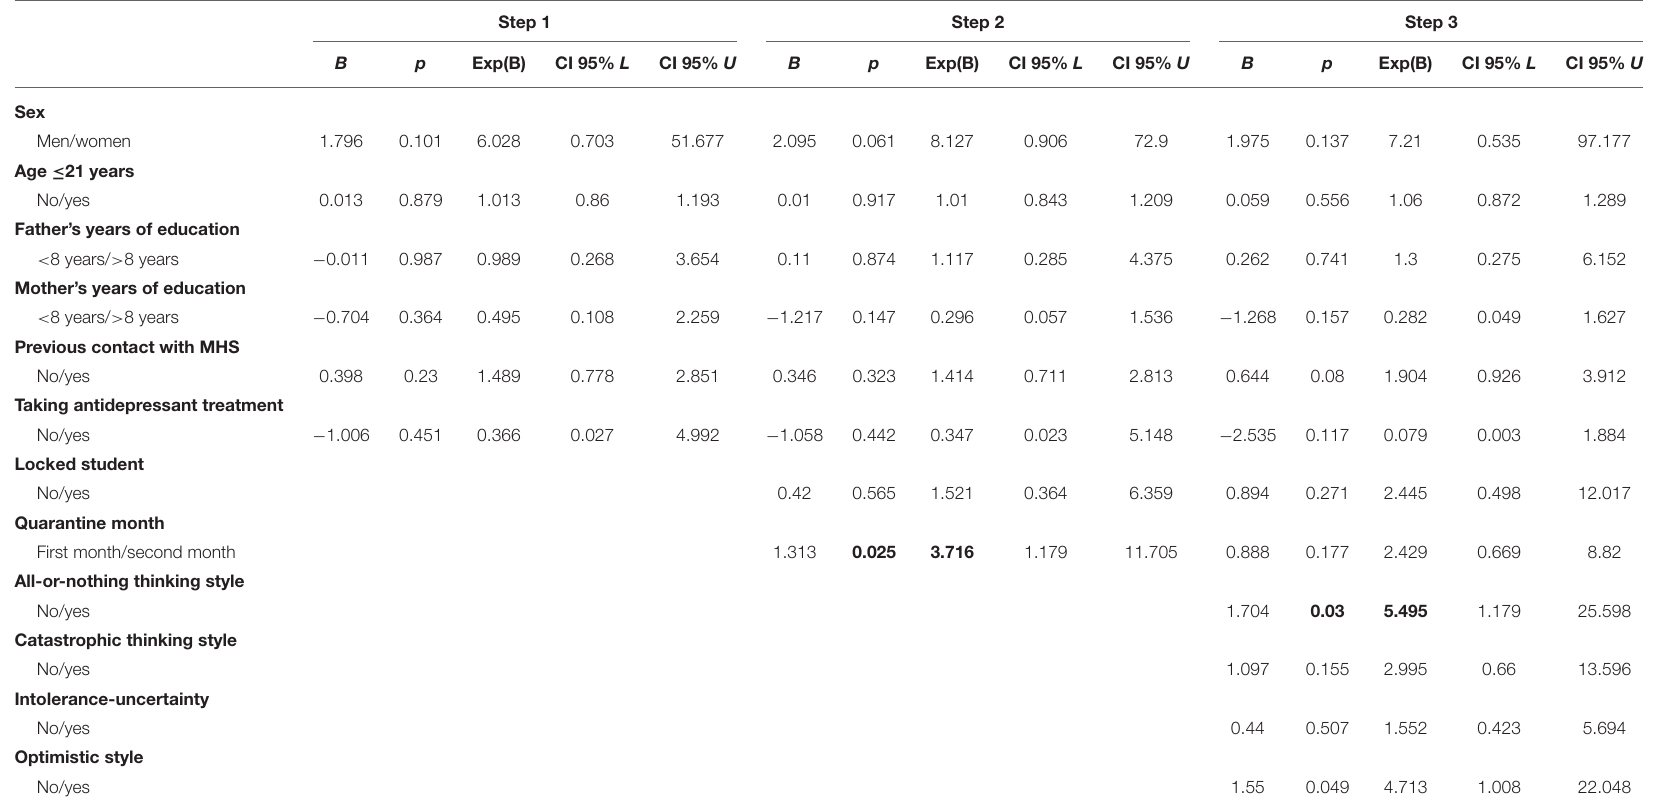
TABLE 6 | Logistic regression analysis for predicting the traumatic impact of COVID-19 lockdown from the IES-R scale (total score > 23). Step 1 Step